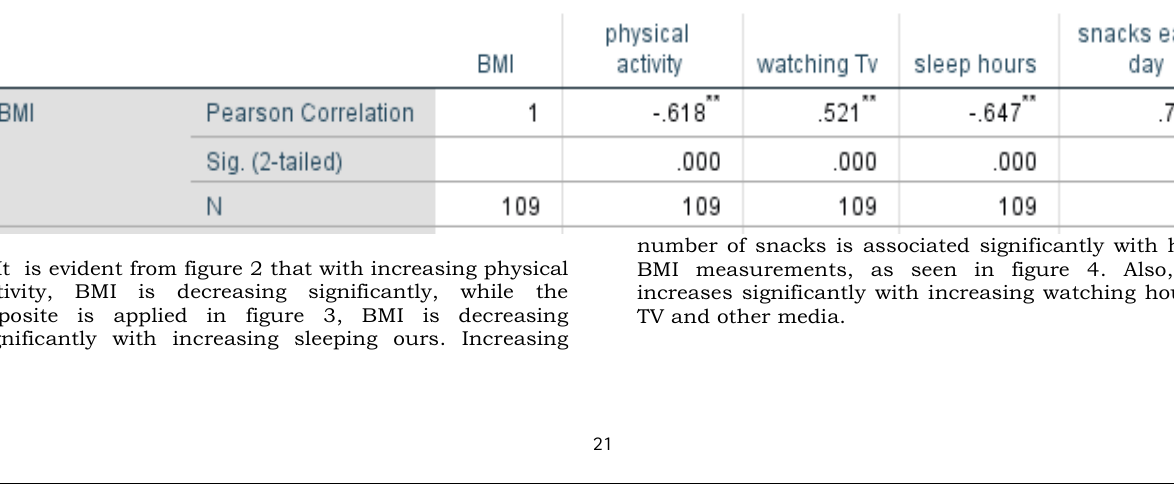
Table 2 Correlation between BMI and certain risk